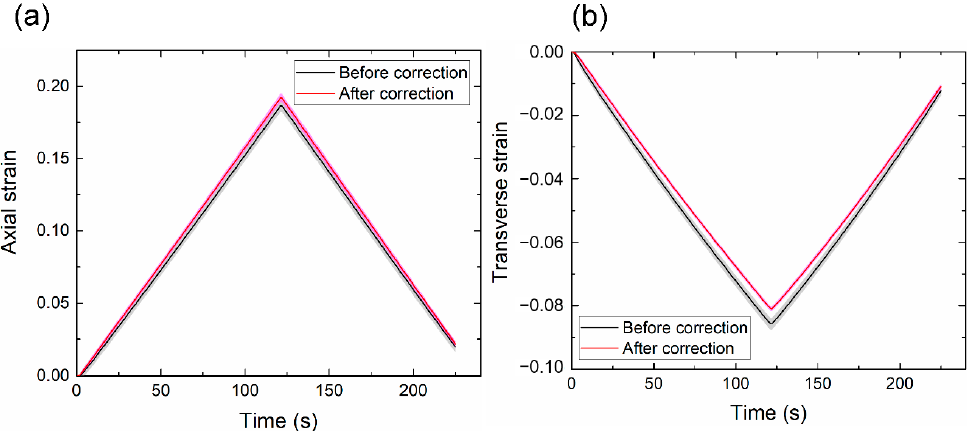
Figure 3. Means and standard deviations of the ( a ) axial strain and ( b ) transverse strain at a speed of 10 mm/min. The shaded areas represent one standard deviation of six samples. The axial and transverse strains were measured simultaneously on the same samples.